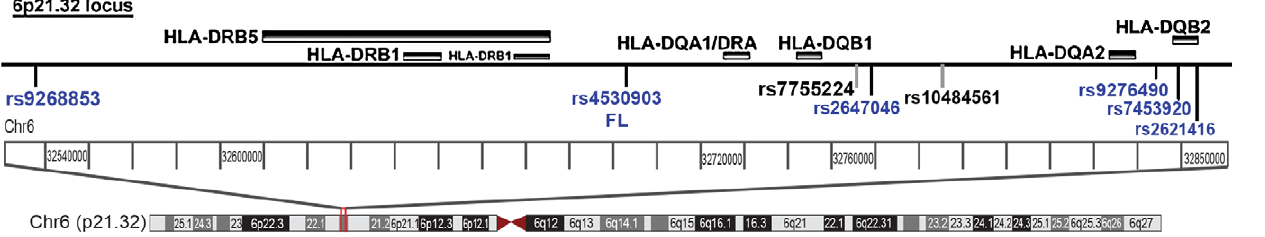
Table 3. Conditional logistic regression analysis for the 6p21.32 SNPs in FL.